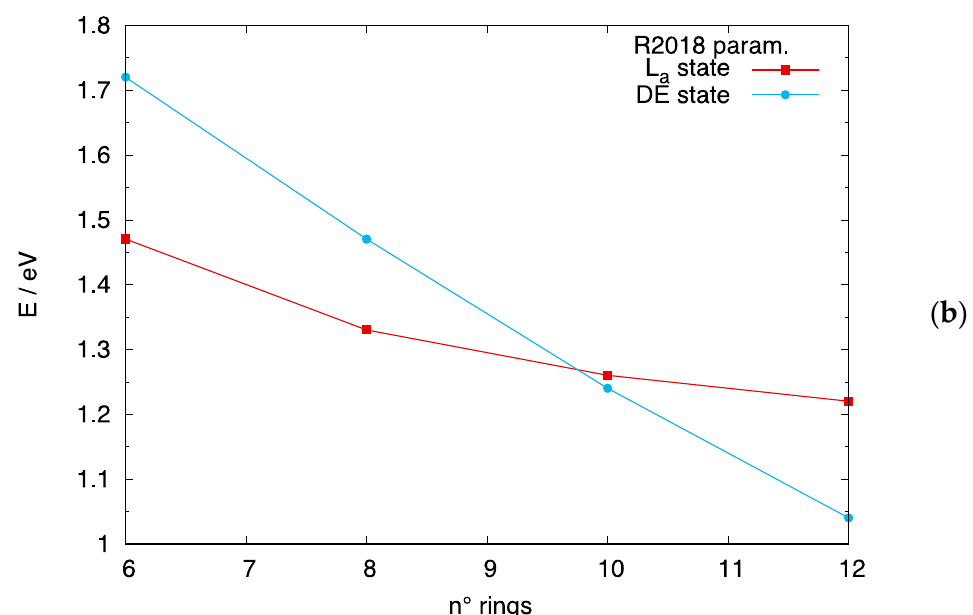
Figure 8. Crossing between the L a and DE states predicted by DFT/MRCI calculations with the R2018 parametrization. ( a ) [n]-acenes : the isolated cyan and red data points correspond to experimental data from ref. [18]; ( b ) [n]-CCs .